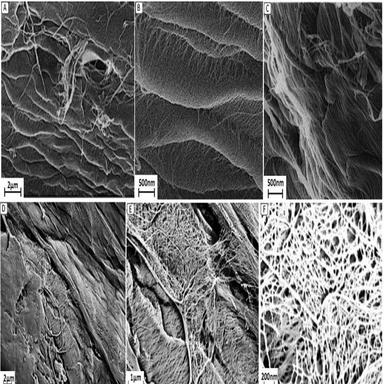
Various comparative HIM (aec) and SEM (def) micrographs on spruce never dried, critical point dried pulp: a) fiber surface at low magnification, b) fiber surface at high magnification, nanofibrils are visible, c) fiber surface at high magnification, nanofibril bundles are visible, d,e) fiber surface with nanofibrils, f) fiber surface at higher magnification, nanofibrils are visible.